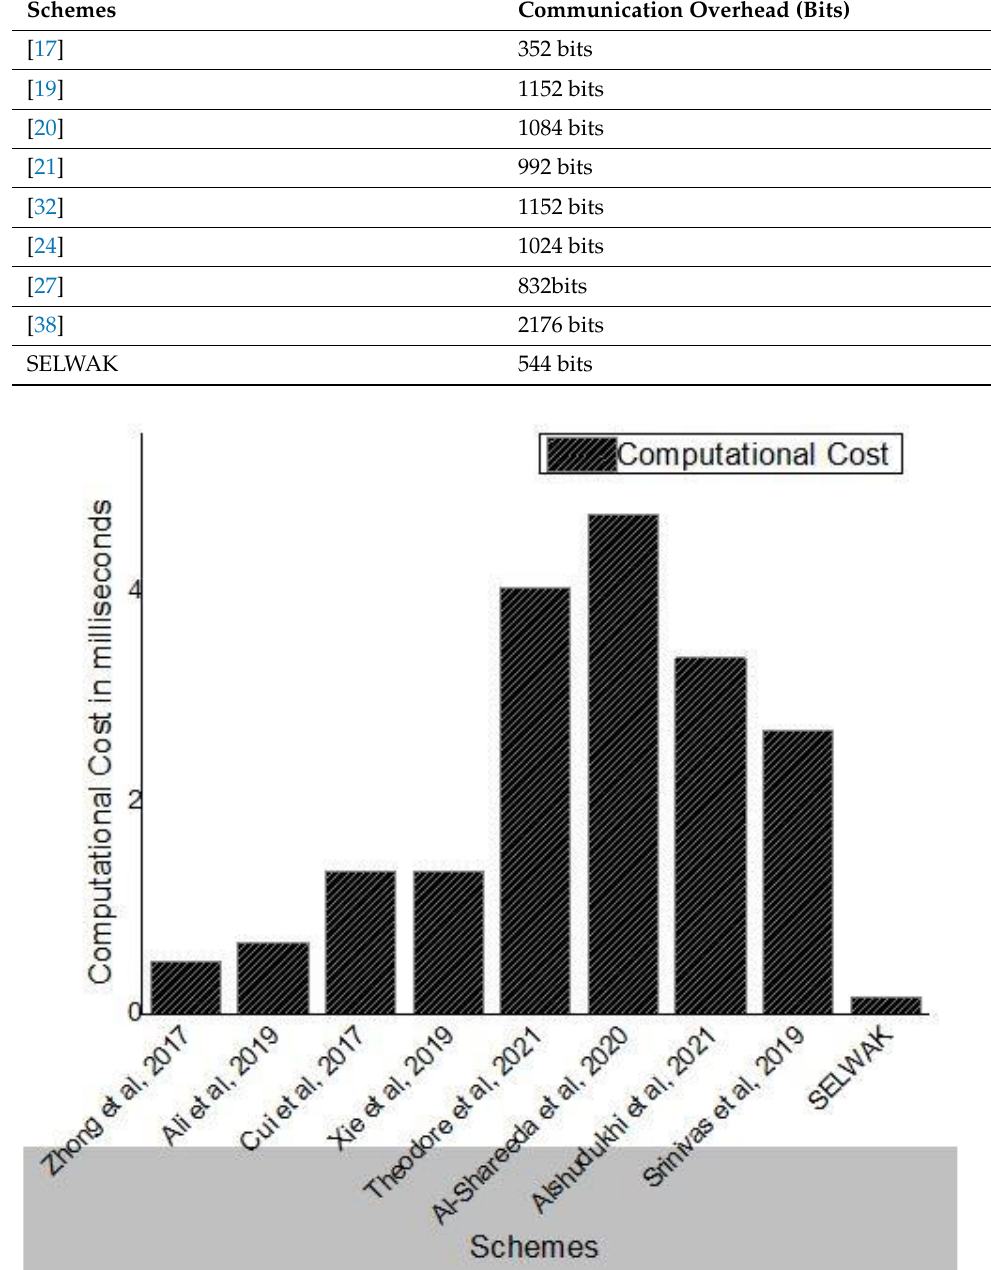
Figure 7. Computation Cost Comparison.